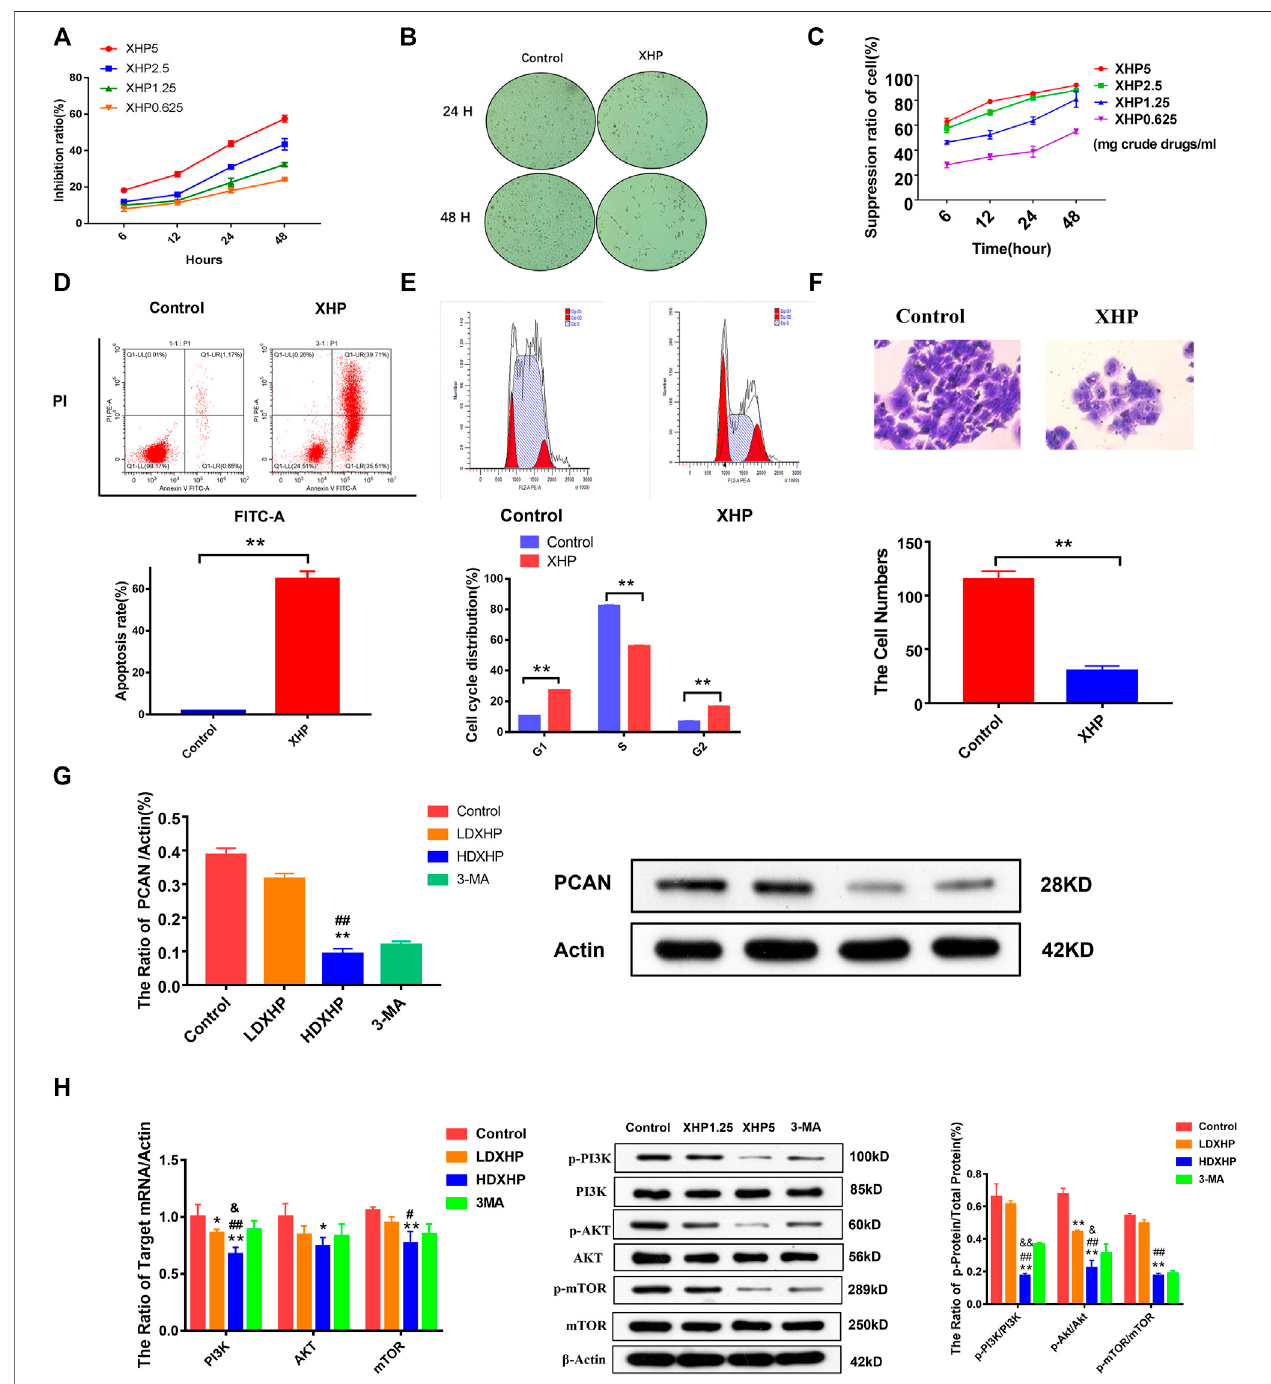
FIGURE 6 | The effect and molecular mechanism of XHP on the proliferation, apoptosis, cell cycle, and invasion of prostate cancer cells. (A) The effect of different concentrations of XHP extract on the proliferation ofPC3 cells at different times. (B) The effects ofXHP extract on the proliferation and morphology of PC3 cells. (C) The effect of different concentrations of XHP extract on the proliferation of LNCaP cells at different times. (D) XHP promoted apoptosis of PC3 cells. (E) XHP exhibited cell cycle. (F) XHP exhibited invasion against PC3 cells. (G) XHP suppressed the protein expression of PCAN in PC3 cells. (H) : XHP restrained the protein and mRNA expression of PI3K, Akt, mTOR, p-pI3K, p-Akt, and p-mTOR in PC3 cells [LDXHP: low-dose XHP (1.25 mg/ml); HDXHP: high-dose XHP (5 mg/ml); *compared to the controlgroup,p ≤ 0.05; **comparedtothecontrolgroup,p ≤ 0.01; # compared tothelowdoseXHP(LDXHP) group (1.25 mg/ml),p ≤ 0.05; ## compared tothelowdose XHP(LDXHP) group, p ≤ 0.01; & compared to the 3-MA group, p ≤ 0.05; && compared to the 3-MA group, p ≤ 0.01].